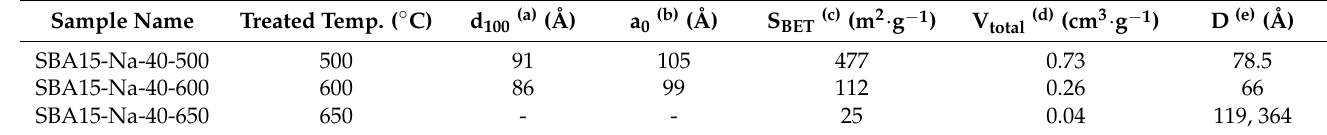
Figure 7. Nitrogen adsorption/desorption isotherm curves ( A ) and pore size distributions ( B ) of (a) SBA15-Na-40-500, (b) SBA15-Na-40-600 and (c) SBA15-Na-40-650 after thermal treatment with different temperatures (500 – 650 °C) using Si/Na = 40. Table 2. Physico-chemical properties of the samples synthesized with different temperatures (500 – 650 °C) using Si/Na = 40.